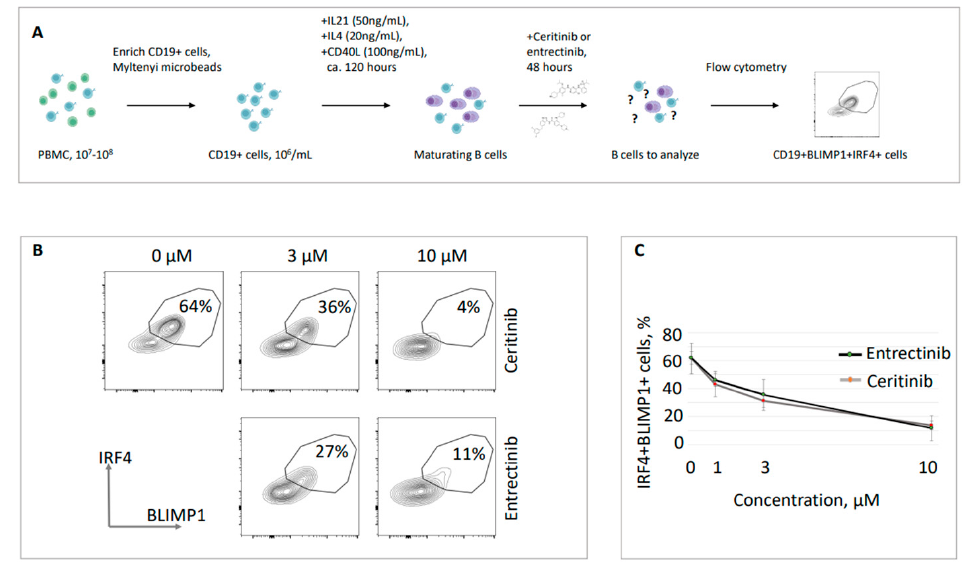
Figure 2. Ceritinib and entrectinib inhibit the proliferation of B lymphocytes in cell culture. ( A ) Schematic overview of the experiment. ( B ) Examples of flow cytometry detecting live, CD19-positive B lymphocytes expressing BLIMP1 and IRF4 (plasma cells). Stimulated mature B lymphocyte populations included 64% of BLIMP1/IRF4 double-positive cells. Following 48 h of treatment with 3 µM and 10 µM of ceritinib, the proportion of BLIMP1/IRF4 double-positive cells reduced to 36% and 4%, respectively. Similarly, following 48 h of treatment with 3 µM and 10 µM of entrectinib, the proportion of BLIMP1/IRF4 double-positive cells reduced to 27% and 11%, respectively. ( C ) Summary of five experiments similar to one shown in ( B ) with standard deviation. Samples from different donors were used to generate every data point.